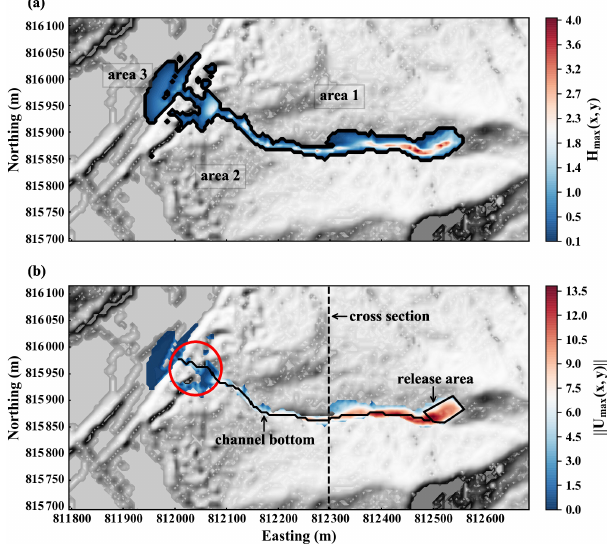
Figure 7. Results of the deterministic simulation HK-DTM. (a) H max (x,y) above a cutoff threshold of 0.1m. The black out- line is the 0.1m contour of H max (x,y) . The area within this outline is regarded as the hazard area. Area 1–3 are denoted for later discus- sions (see Sect. 6.2.1). (b) (cid:107) U max (x,y) (cid:107) above a cutoff threshold of 0.01ms − 1 . The relatively high elevation area within the red circle decelerates and holds back the flow material. The channel bottom and cross section are denoted for later discussions (see Sect.